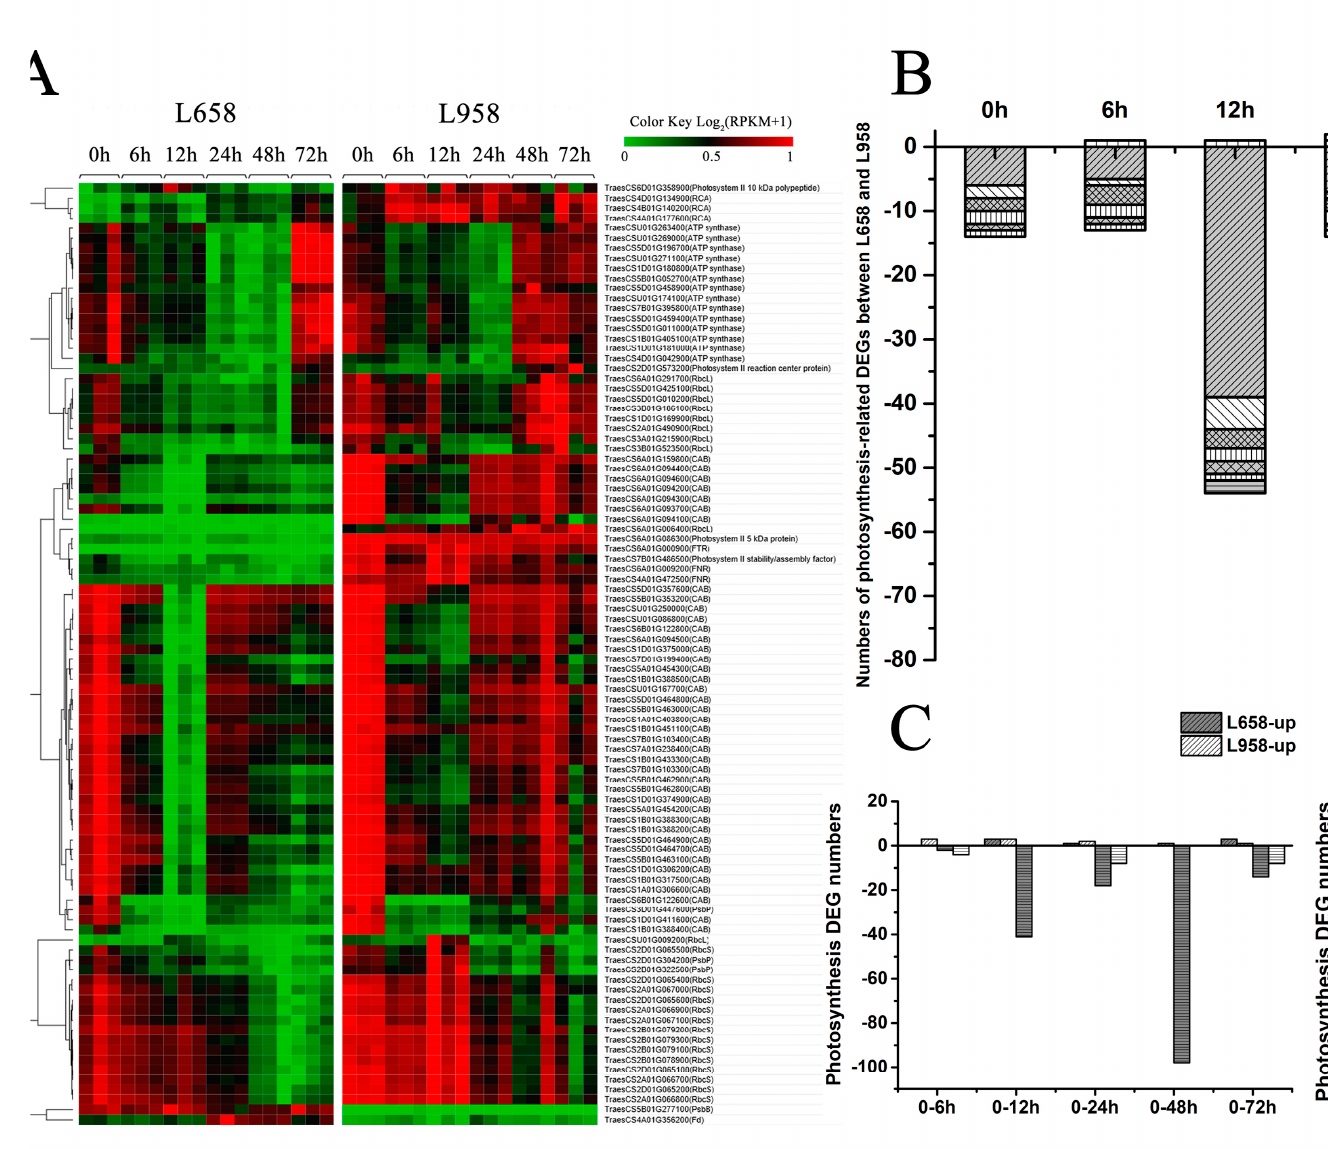
Figure 3. Number of DEGs and expression patterns of photosynthesis-related genes. ( A ) Di ff erent expression patterns of photosynthesis-related DEGs in L658 and L958 at various time points on the basis of log2 of RPKM values + 1; the green colour represents low expression levels, and the red colour represents high expression levels. ( B ) Number of di ff erent photosynthesis-related DEGs between L658 and L958 at various time points. The negative numbers and positive numbers represent downregulatedandupregulatedDEGsinL658comparedwithL958, respectively. ATPase: ATPsynthase; FTR: ferredoxin-thioredoxin reductase; Fd: ferredoxin; FNR: ferredoxin: NADP + oxidoreductase; RCA: Rubisco activase; RbcS / L: ribulose bisphosphate carboxylase small chain / large chain; Cab: chlorophyll a / b-binding protein. ( C ) Number of photosynthesis-related DEGs in L658 and L958 at various inoculation time points compared with 0 h (left) and between two adjacent time points